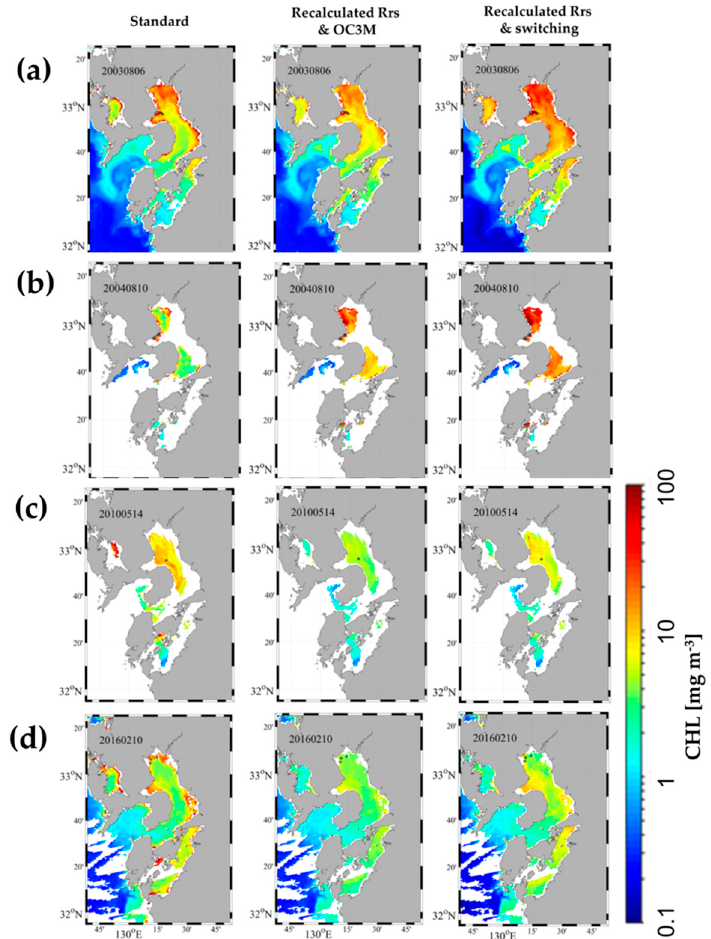
Figure 10. Comparison between standard and improved MODIS Chl-a. ( a ) 6 August 2003; ( b ) 10 Comparison between standard and improved MODIS August 2004; ( c ) 14 May 2010; ( d ) 10 February 2016.